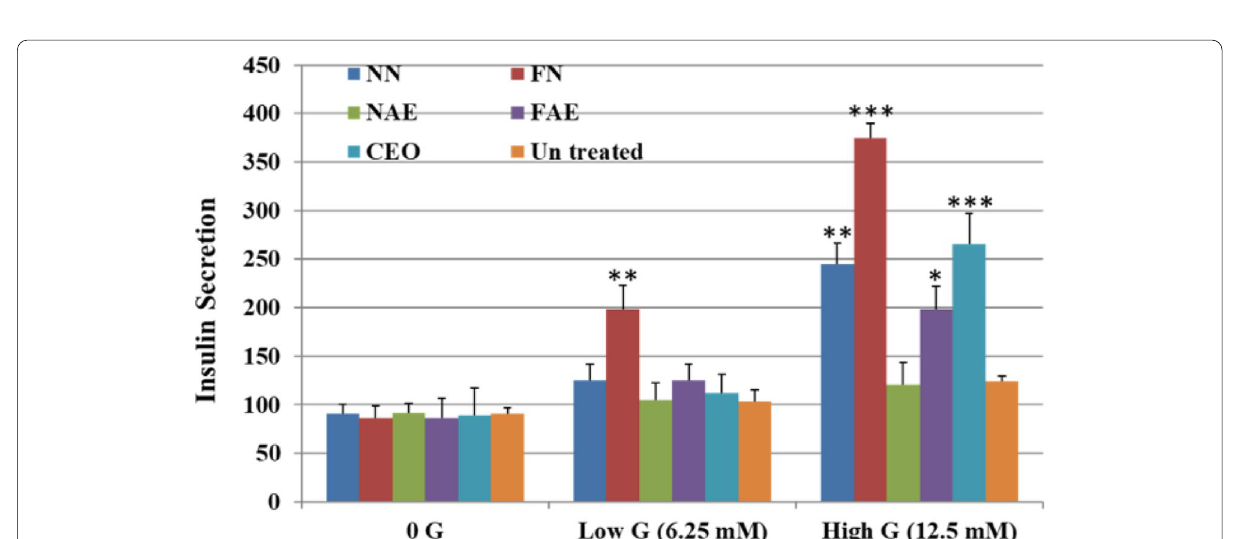
Fig. 12 The insulin secretion level by RIN-5 cell culture in glucose-free, low glucose, and high glucose levels for